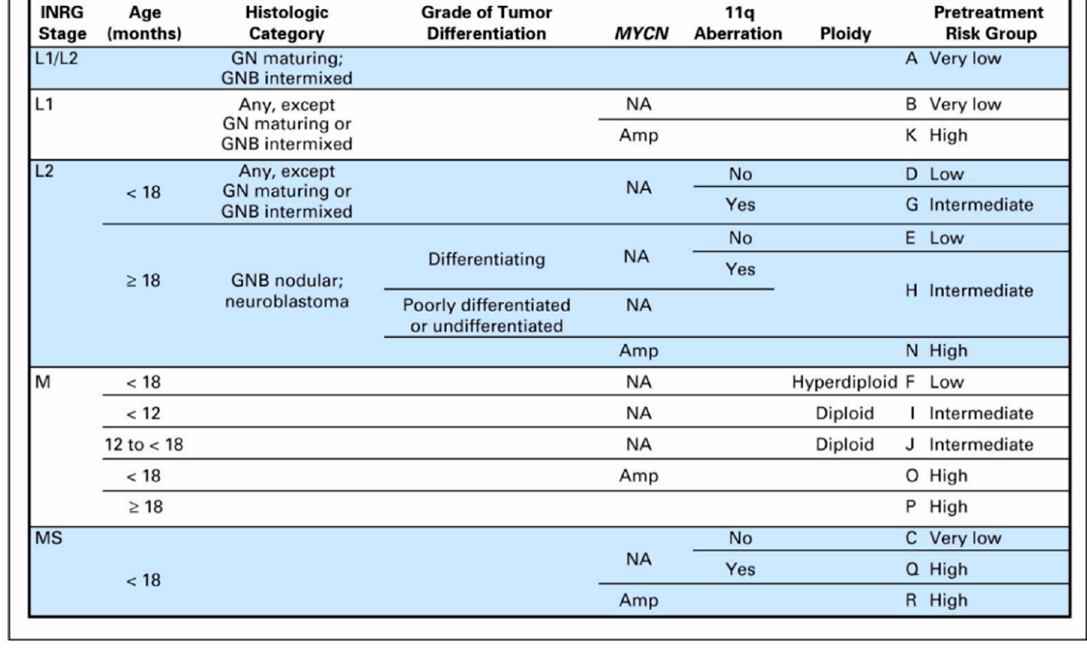
Figure 2. International Neuroblastoma Risk Group (INRG) pre-treatment classification system [12] (Reprinted with permission from Cohn S. et al.: J. Clin. Oncol. 27(2): 289–297. © 2009 American Society of Clinical Oncology. All rights reserved.). GN—ganglioneuroma; GNB—ganglioneuroblastoma; Amp—amplified; NA—not amplified; blank fields represent any value.